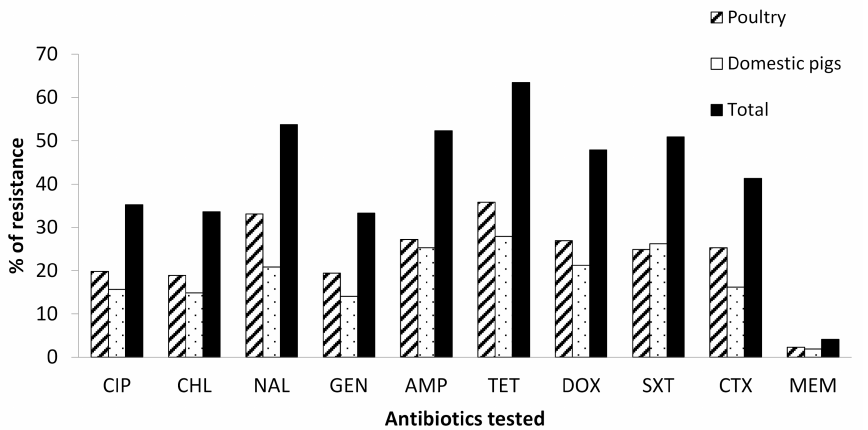
Figure 1. Percentage of antibiotic resistance from the poultry and domestic pig isolates. Key: CIP, ciprofloxacin; CHL, chloramphenicol; NAL, nalidixic acid; GEN, gentamycin; AMP, ampi- cillin; TET, tetracycline; DOX, doxycycline; SXT, trimethoprim/sulfamethoxazole; CTX, cefotaxime; MEM,